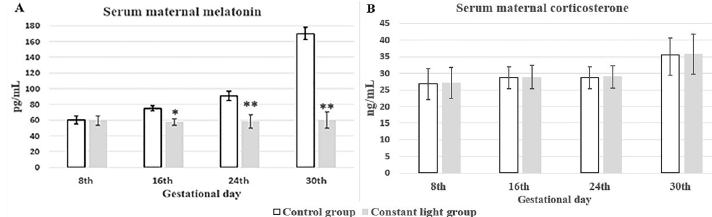
Figure 1. A , Means ± SD of maternal nocturnal serum melatonin and ( B ) serum corticosterone among the two studied groups at the 8th, 16th, 24th, and 30th gestational day. *P o 0.05, **P o 0.001 vs control group at same gestational day (unpaired t